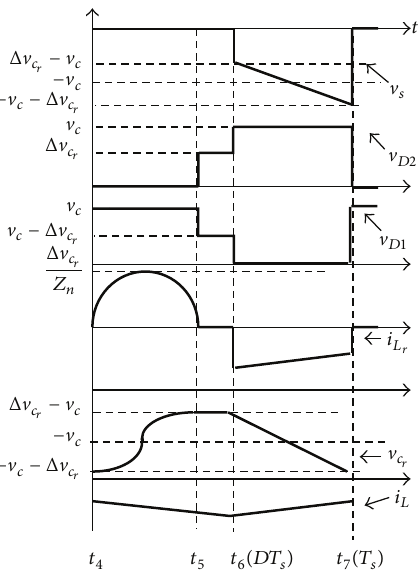
Figure 5: The key waveform of the converter with negative input